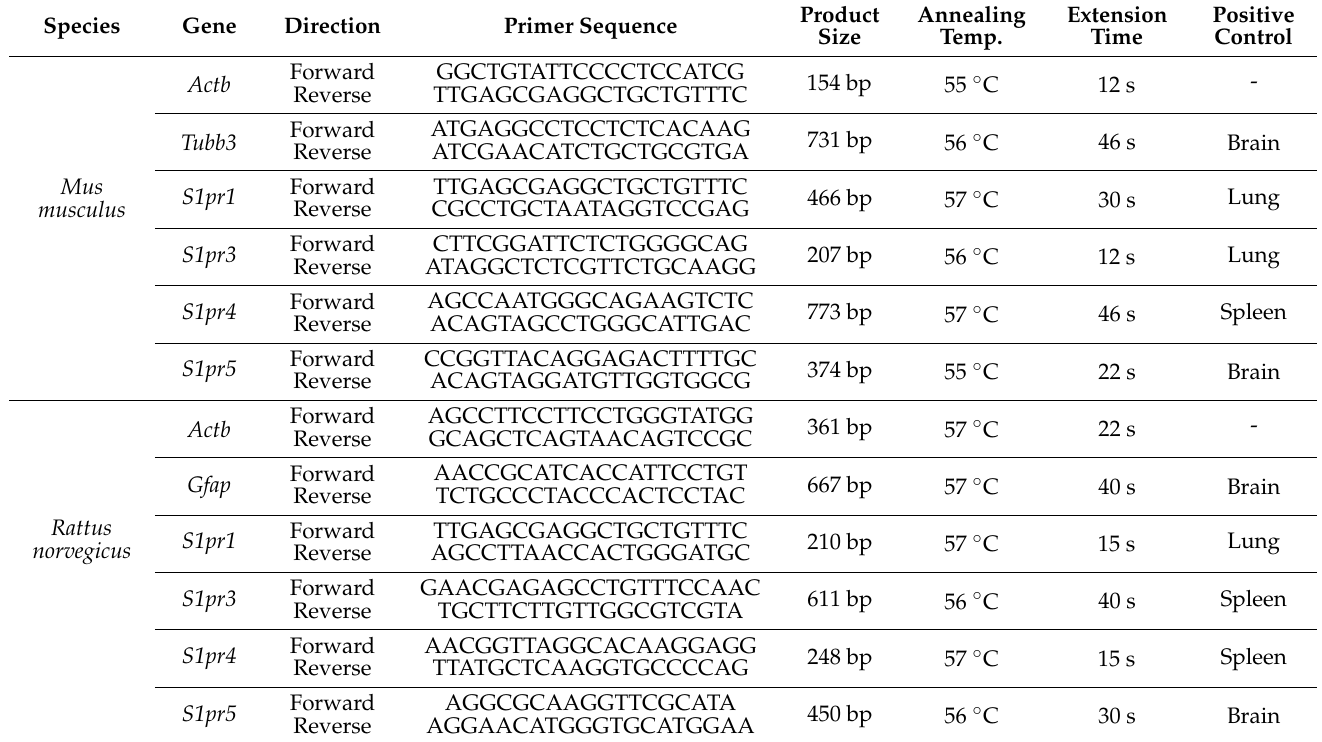
Table 5. Primers used for RT-PCR.